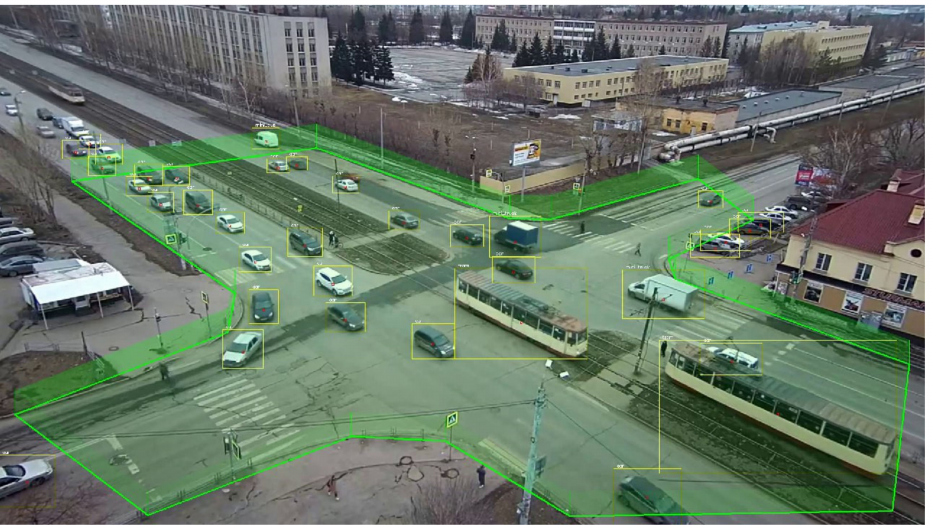
Figure 2. Video frame of the neural network at the intersection of Lenin av.-Engels str. (Chelyabinsk,